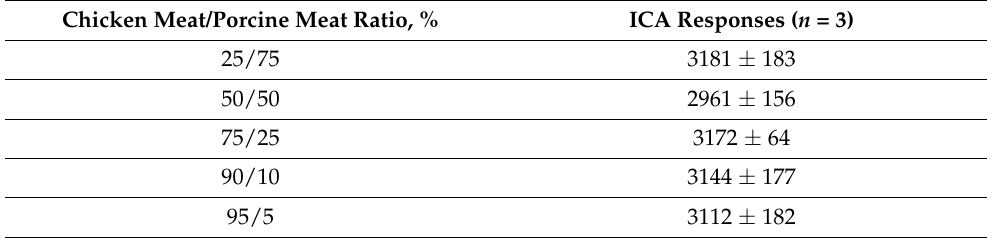
Table 1. ICA responses in the analysis of mixtures of chicken and pork minces.